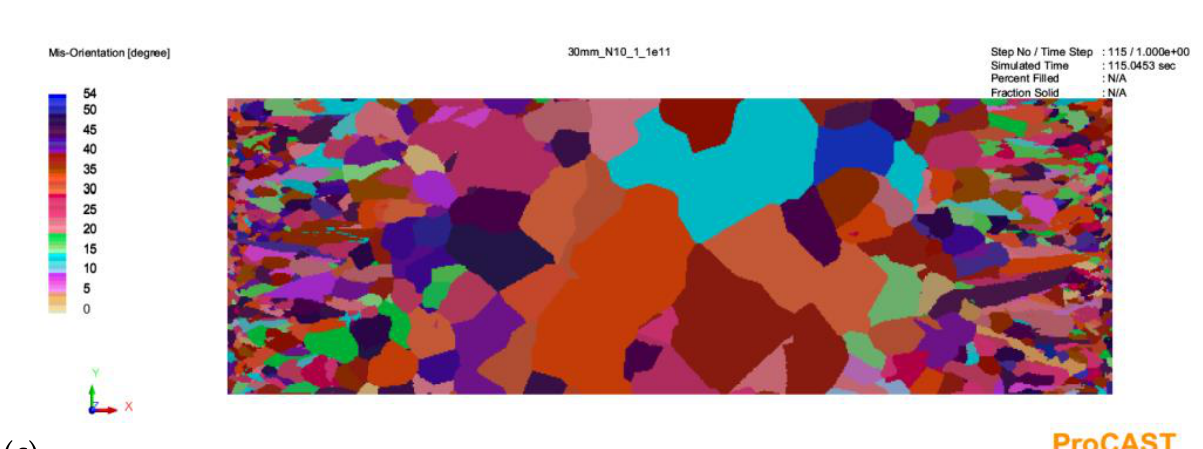
Figure 4. Simulation results for a casting wall thickness of 30 mm with a given number of austenite nucleation sites in the amount of: ( a )—10 9 ; ( b )—10 10 ; ( c )—10 11 .